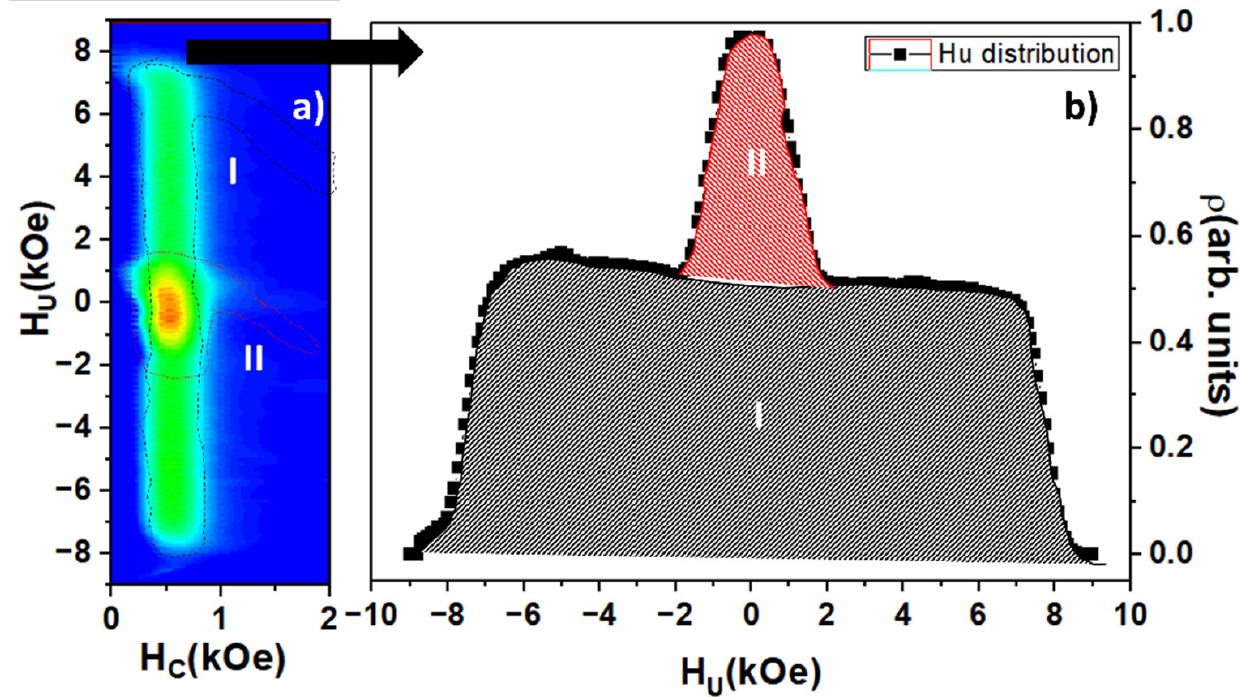
Figure 4. ( a ) FORC diagram of the bisegmented FeCo nanowire array measured along the parallel direction of applied field with respect to the nanowires long axis. Two distributions, I and II, are highlighted as an eye guidance. ( b ) FORC interaction field profile (Hu) where both contributions, I (red) and II (black), are also highlighted.